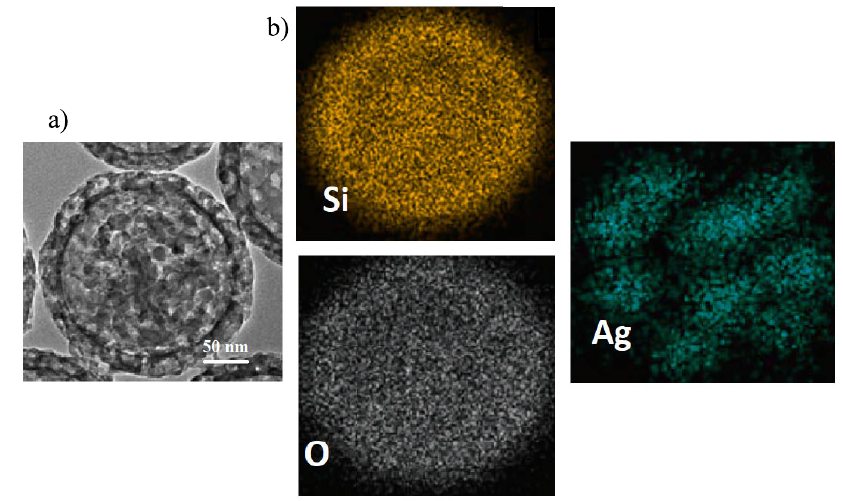
Figure 3. SEM image ( a ) and EDX elemental mapping ( b ) of Si, O and Ag, carried out on a portion accidentally detached from SFT-Ag-PMA SiO 2